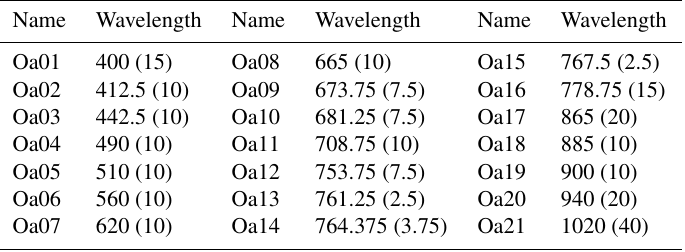
Table 1. OLCI spectral bands. Name and central wavelengths (bandwidth) in nanometres (see Nieke et al., 2012). Name